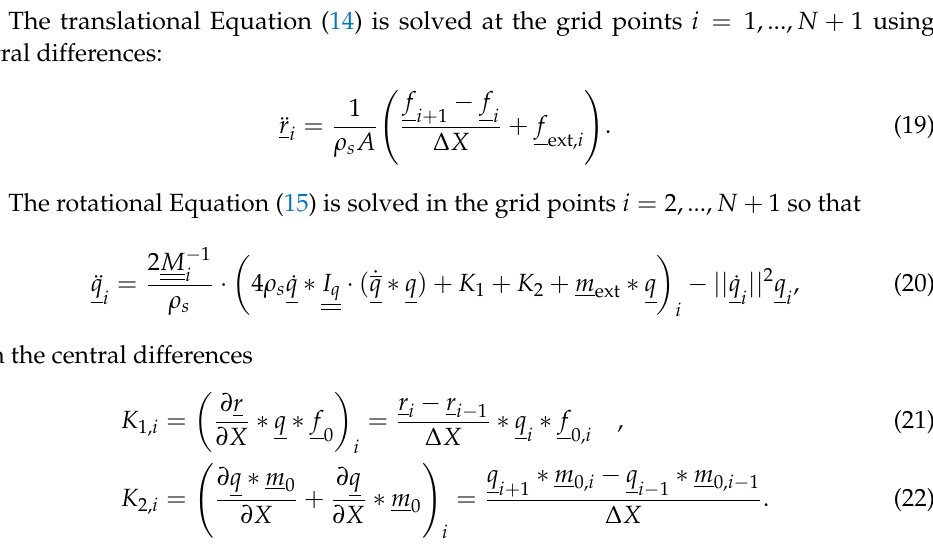
Figure 1. Definition of the discrete rod line ( solid line ) using N bluesegments of length ∆ X . The blue- segment edges are marked as points, the segment centres as bars. The ( dashed lines ) show the ghost point extensions at both ends of the